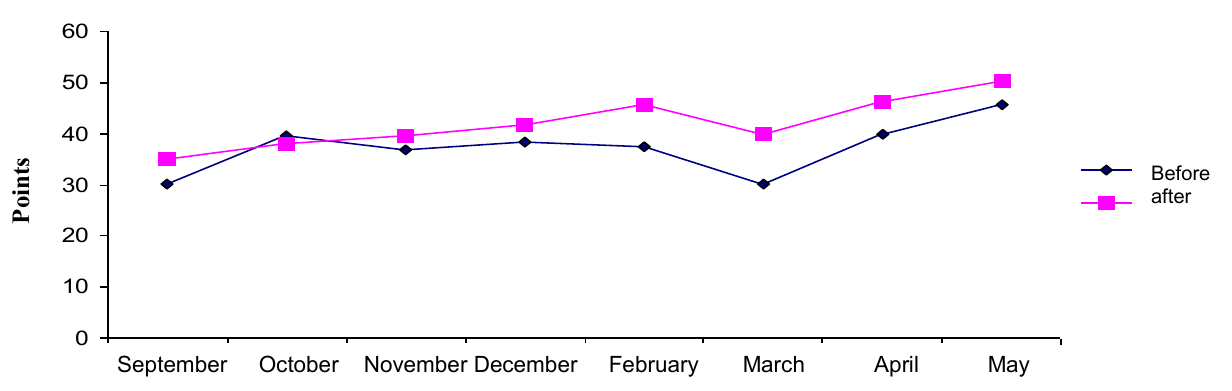
Fig.3. Dynamics of EG students’ activity in the process of experimental training.